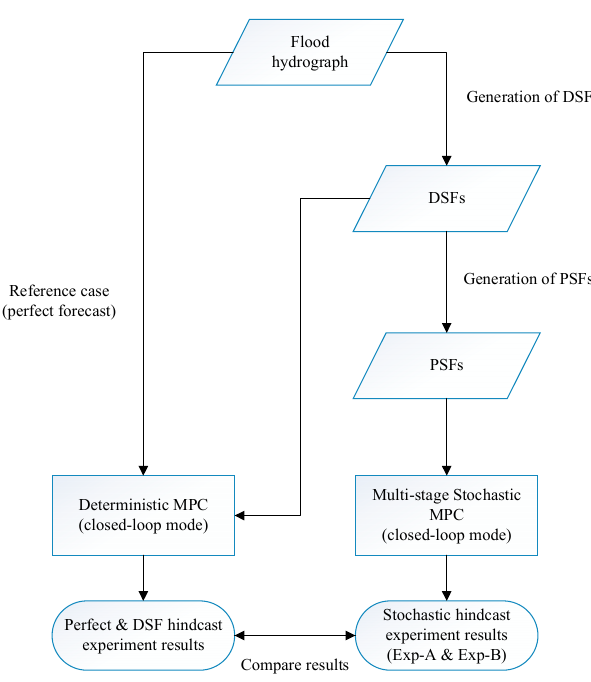
Figure 1. The general framework of the experiments. DSFs stands for Deterministic Streamflow Forecasts. PSFs stands for Probabilistic Streamflow Forecasts. MPC stands for Model Predictive Control.